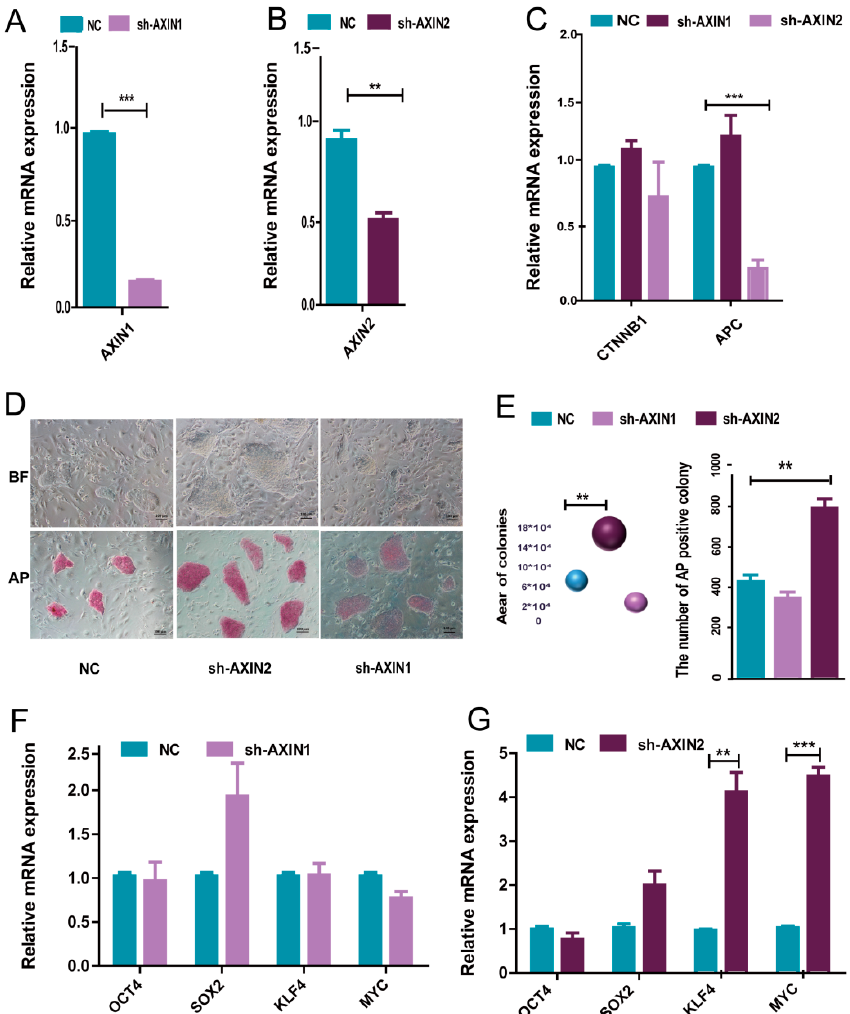
Figure 2. Knockdown of AXIN2 showed higher pluripotency in piPSCs. ( A ) qPCR analysis of the expression levels of AXIN1 in the control (NC) and knockdown AXIN1 (sh-AXIN1) groups; ( B ) qPCR analysis of the expression levels of AXIN2 in the control (NC) and knockdown AXIN2 (sh-AXIN2) groups; ( C ) qPCR analysis of the expression levels of and APC in NC, sh-AXIN1, and sh-AXIN2 groups; ( D ) representative image of colonies and AP staining after 5 days of clonal growth in the NC, sh-AXIN1, and sh-AXIN2 groups; the scale bar represents 100 µ m; ( E ) the area of NC, sh-AXIN1, and shAXIN2 colonies; the quantities of AP positive colonies in the NC, sh-AXIN1, and sh-AXIN2 groups; ( F ) qPCR analysis of endogenous OCT4 , SOX2 , KLF4 , and MYC in NC and sh-AXIN1 groups; ( G ) qPCR analysis of endogenous OCT4 , SOX2 , KLF4 , and MYC in NC and sh-AXIN2 groups; ** represents p < 0.001, and *** represents p < 0.0001.